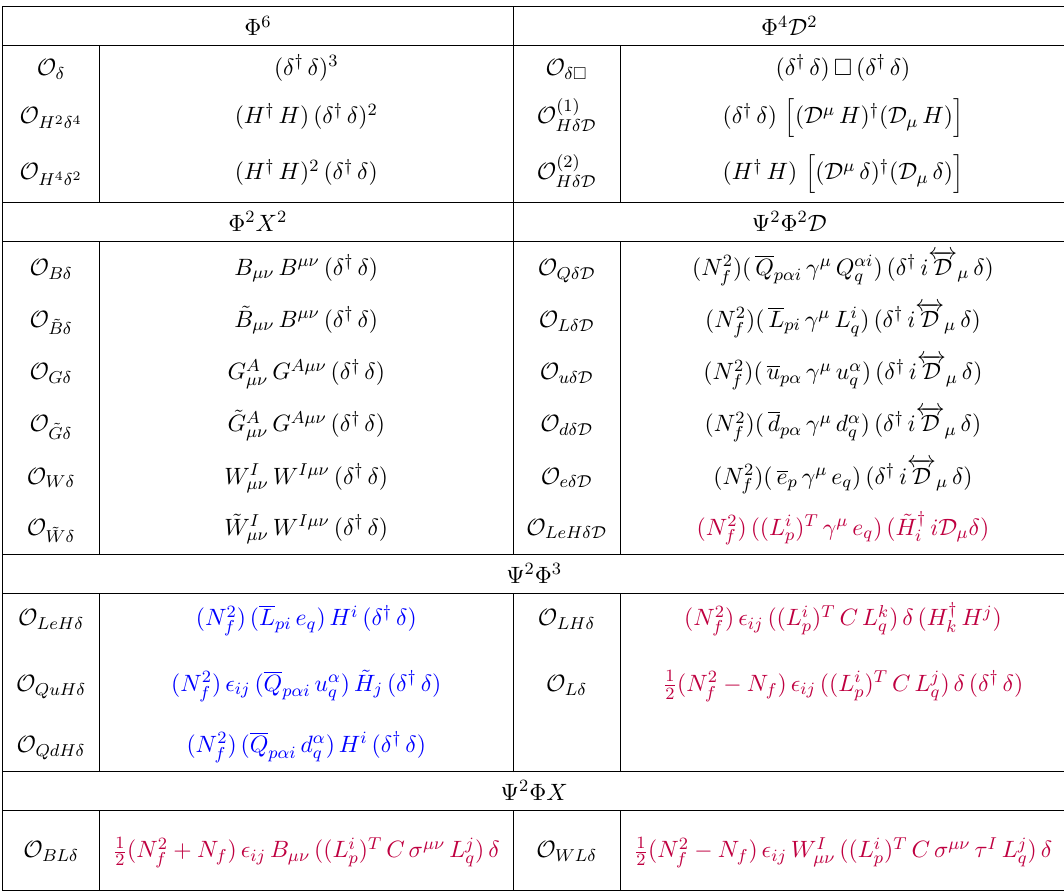
Table 4 . SM extended by Singly Charged Scalar ( δ ): additional operators of dimension 6. Boxed operators vanish for single flavour. δ , δ † represent δ + and δ − respectively. Here i, j and α are the SU(2) and SU(3) indices respectively. τ I is SU(2) generator. A = 1 , 2 , · · · , 8 and I = 1 , 2 , 3